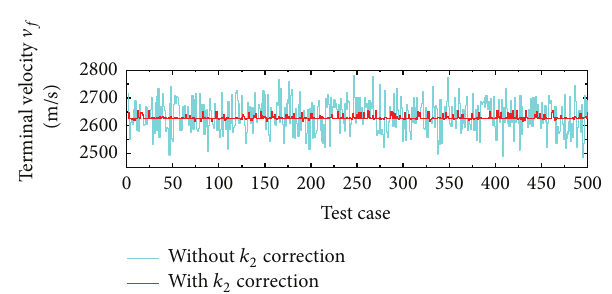
Figure15:Effectofterminalvelocitycontrolthrough 𝑘 2 adjustment.